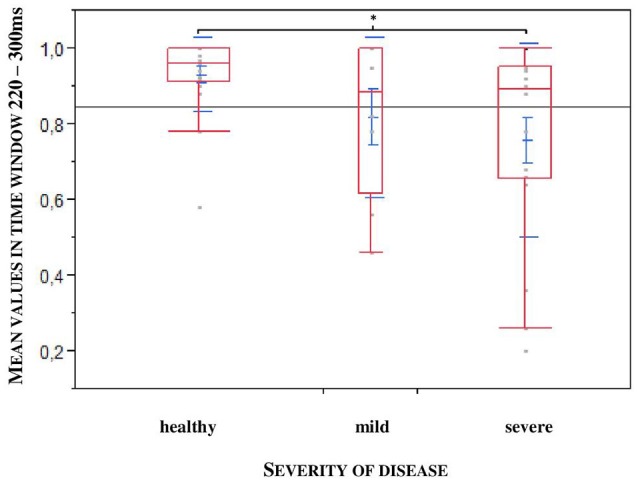
Larger time window depending on the severity of the disease (mild: H&Y stage 1–2,5; severe: H&Y stage 3–4). Significance especially between healthy controls and severe affected patients. (*p = 0.0317).